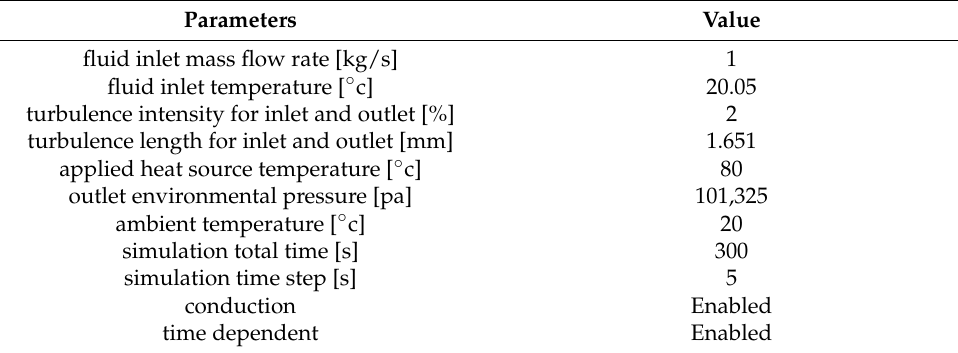
Table 1. SOLIDWORKS Flow Simulation parameters. Parameters Value fluid inlet mass flow rate [kg/s] 1